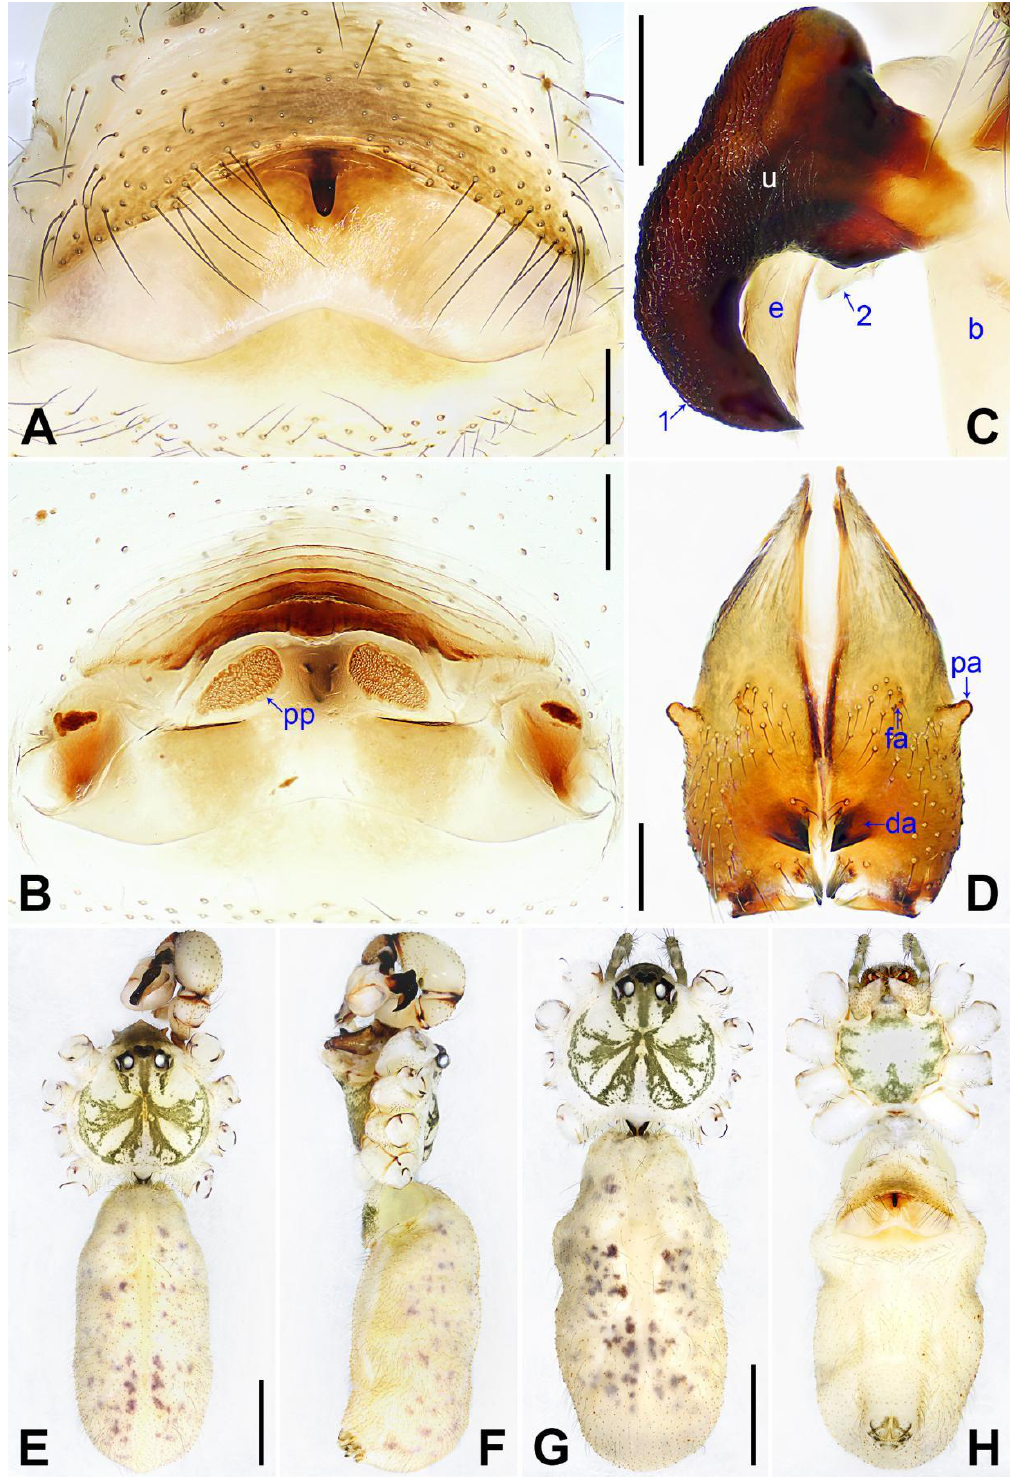
Figure 18. Pholcus zhongyang sp. nov., holotype male ( C – F ) and paratype female ( A , B , G , H ): ( A ) epigyne, ventral view; ( B ) vulva, dorsal view; ( C ) bulbal apophyses, prolateral view (arrow 1 points at distal apophysis, arrow 2 points at “pseudo-appendix”); ( D ) chelicerae, frontal view; ( E ), ( G ) habitus, dorsal view; ( F ) habitus, lateral view; ( H ) habitus, ventral view. da = distal apophysis, e = embolus, fa = frontal apophysis, pa = proximo–lateral apophysis, pp = pore plate, u = uncus. Scale bars: ( A – D ) = 0.20 mm; ( E – H ) = 1.00 mm.